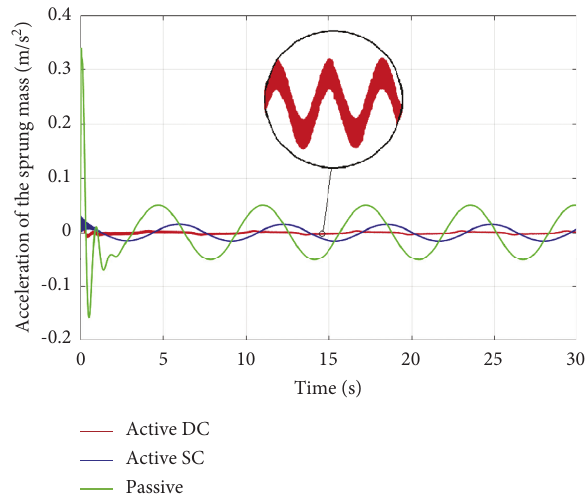
Figure 9: Acceleration of the sprung mass (m/s 2